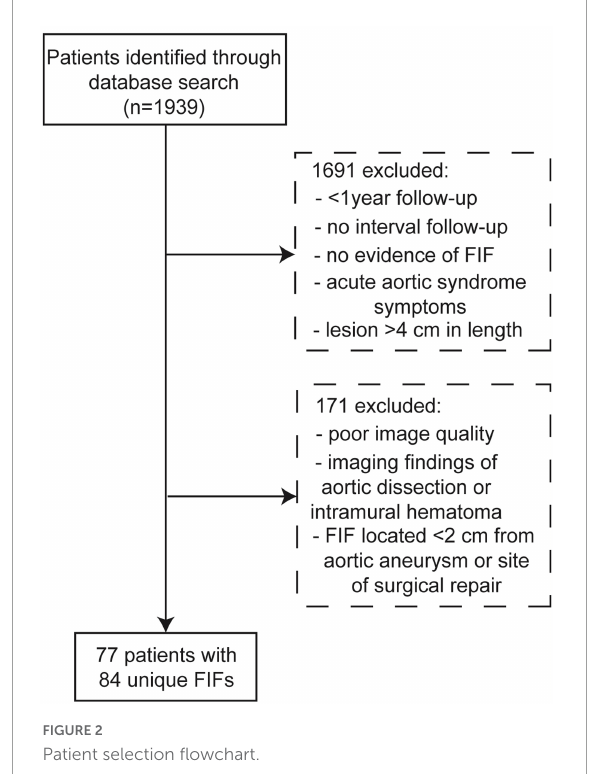
FIGURE2 Patient selection